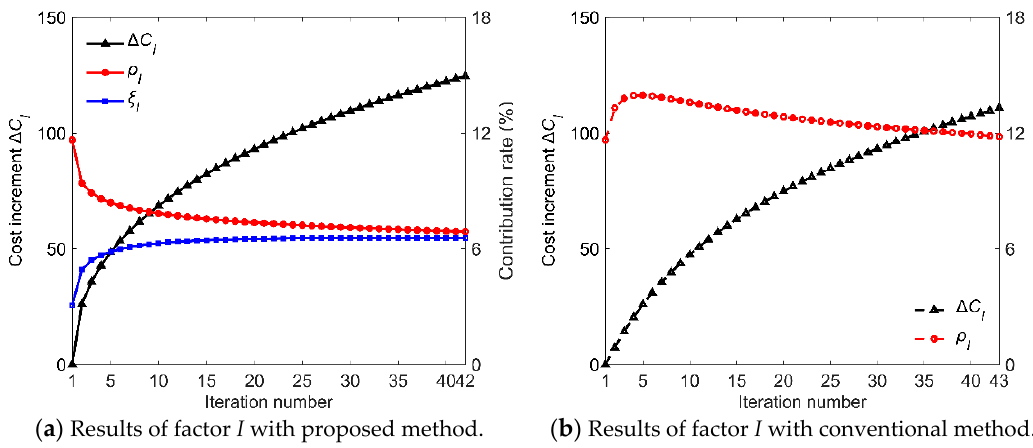
Figure 13. Results of factor I with proposed and conventional method.